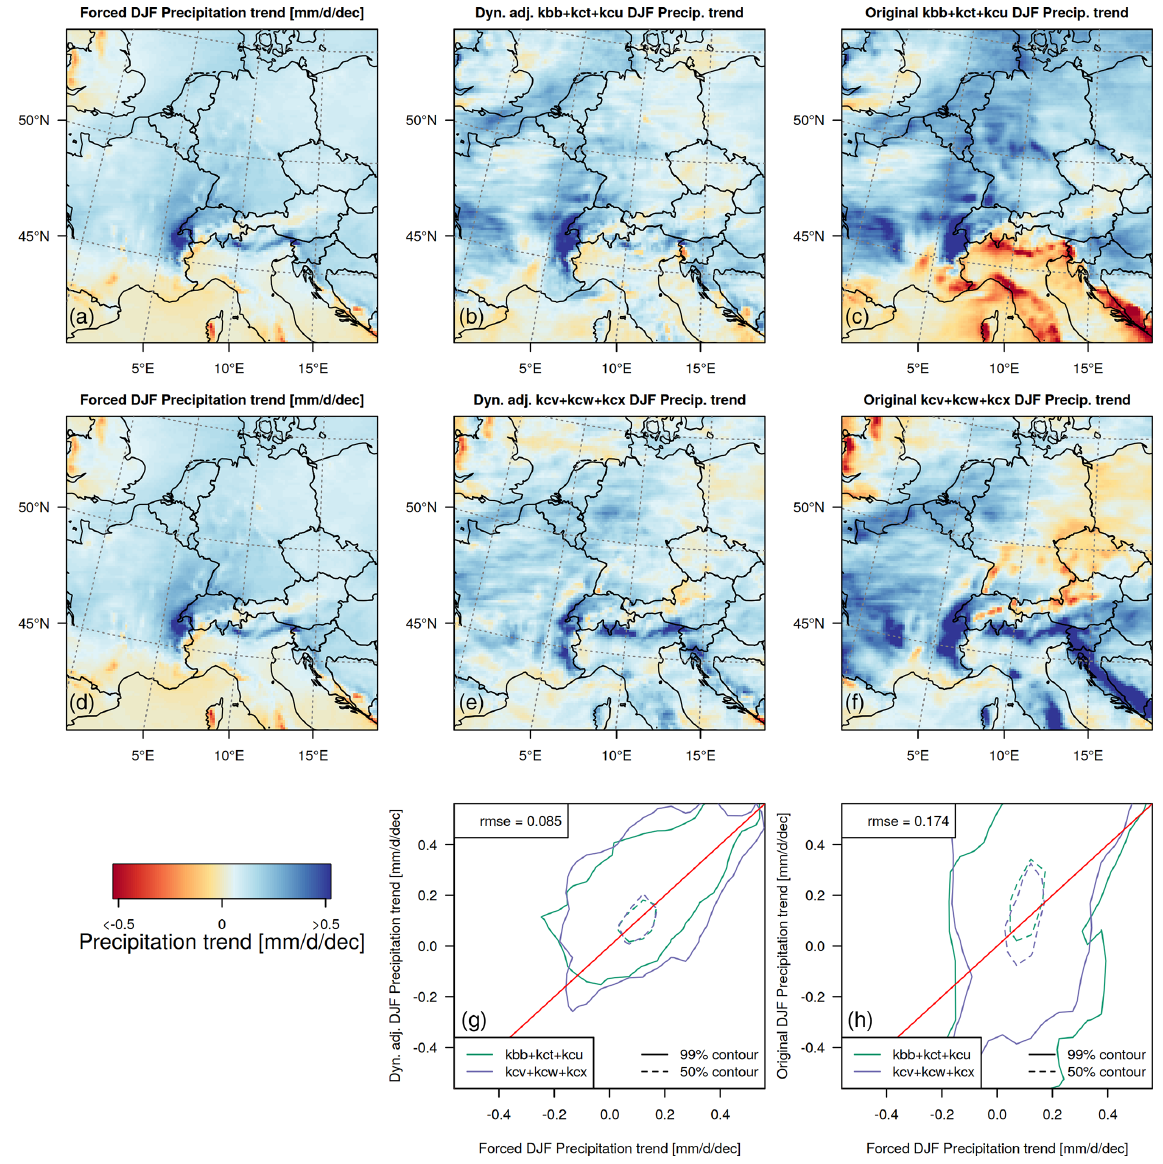
Figure 10. Dynamical adjustment of 50-year winter precipitation trends (2020–2069) under the “EOF1+” regime (25% of all days that project strongest on the first EOF, i.e. those that show a strong westerly flow). (a, d) Linear forced winter precipitation trends under the “EOF1+” regime (2020–2069). (b, e) Linear 50-year winter precipitation trends in an average of three randomly selected dynamically ad- justed ensemble members. (c, f) Linear 50-year winter precipitation trends in an average of three corresponding original ensemble members. (g, h) Scatter plots of 50-year precipitation trends in the forced response against 50-year precipitation trends over land in dynamically adjusted (g) and originally simulated ensemble members (h)